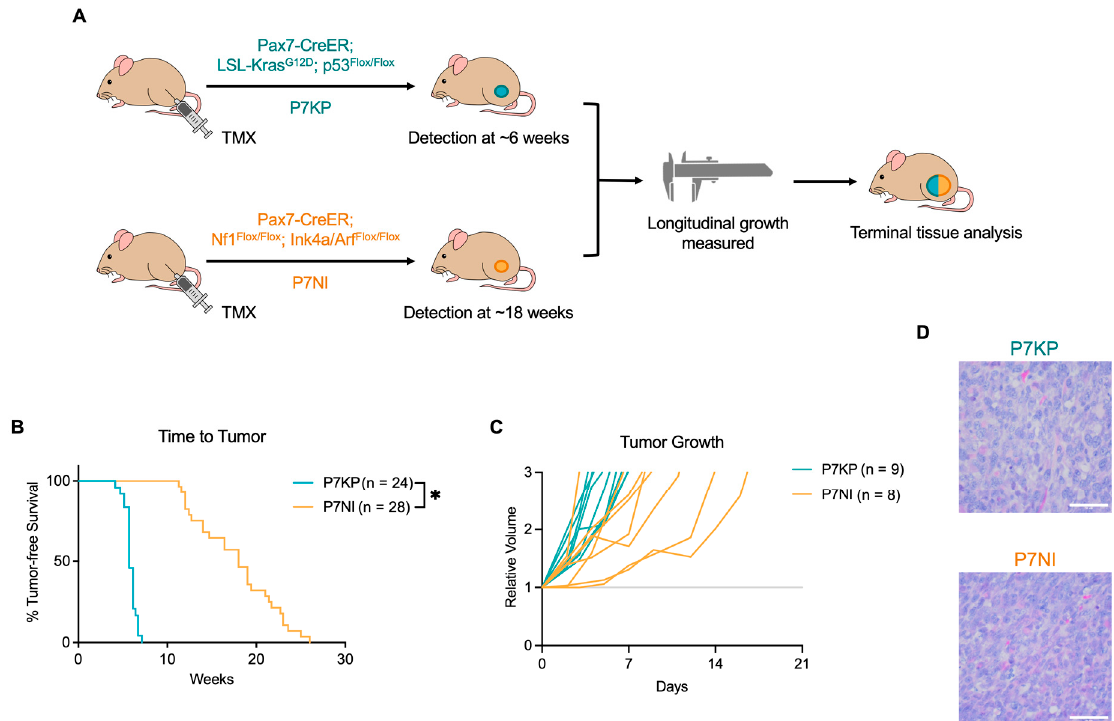
Figure 1. P7KP and P7NI tumor initiation, growth, and histology. ( A ) P7KP and P7NI tumors were induced using intramuscular injection of tamoxifen (TMX) to locally delete Trp53 and activate oncogenic Kras G12D (P7KP) or to locally delete Nf1 and Ink4a/Arf (P7NI). Following tumor initiation, tumor dimensions were measured by caliper three times weekly and terminal tumor tissue was collected for analysis. ( B ) P7NI tumors initiated significantly slower than P7KP tumors. ( C ) P7NI tumors also displayed a broader range of growth rates than P7KP tumors. ( D ) P7KP and P7NI tumors share similar histologic features including cells with high cytologic variability and eosinophilic cytoplasms. Scale bar: 50 µM. Log-rank (Mantel-Cox) tests used to analyze B. * p < 0.05.